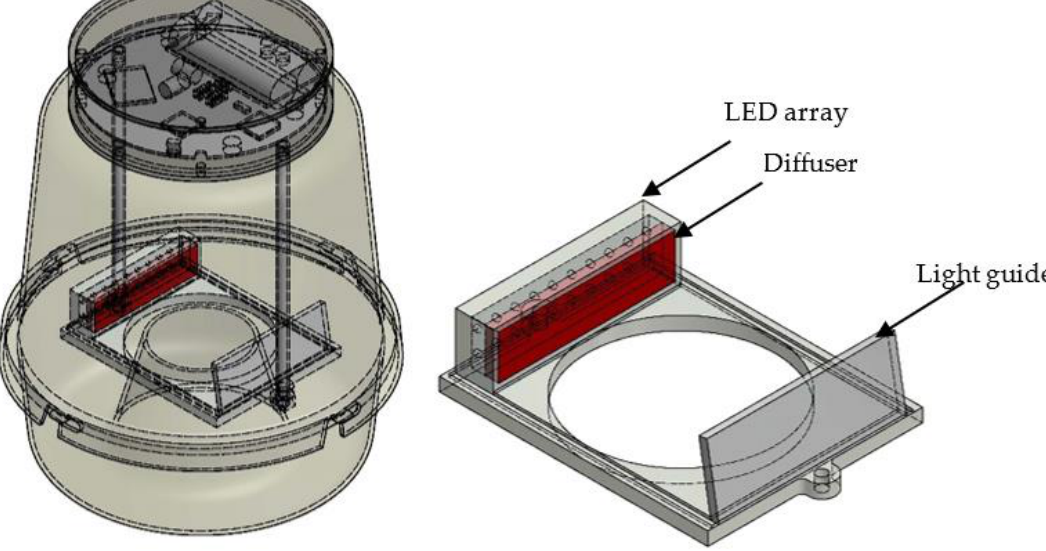
Figure 1. Schematic diagram of the automated monitoring trap ( a ) and enlarged details of the optical sensor ( b ).